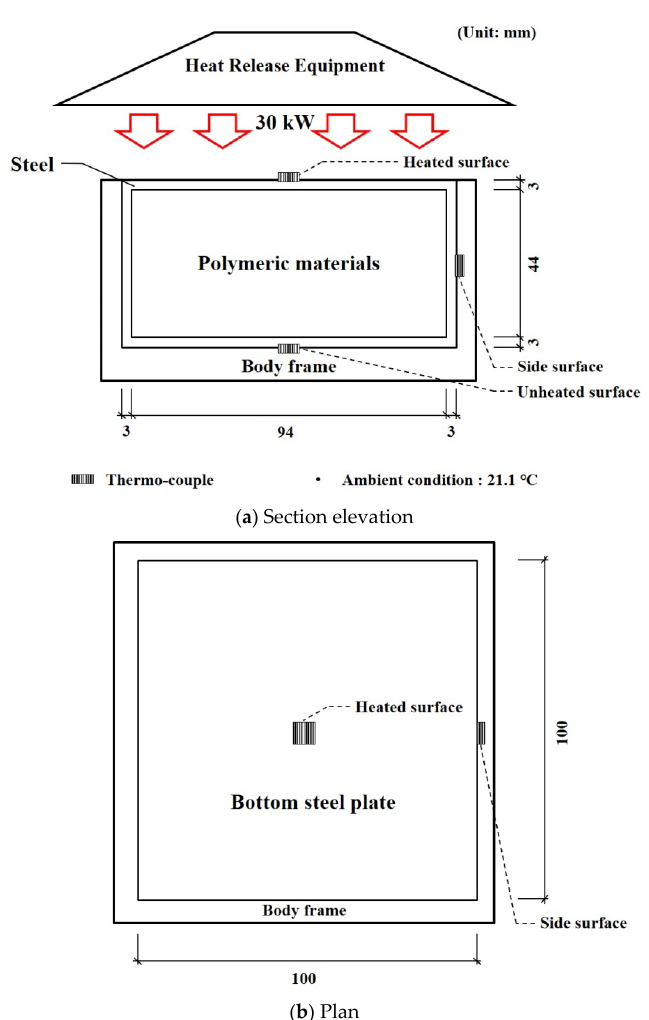
Figure 6. Set-up of furnace tests: ( a ) Section elevation ( b ) Plan. Materials 2020 , 13 , x FOR PEER REVIEW